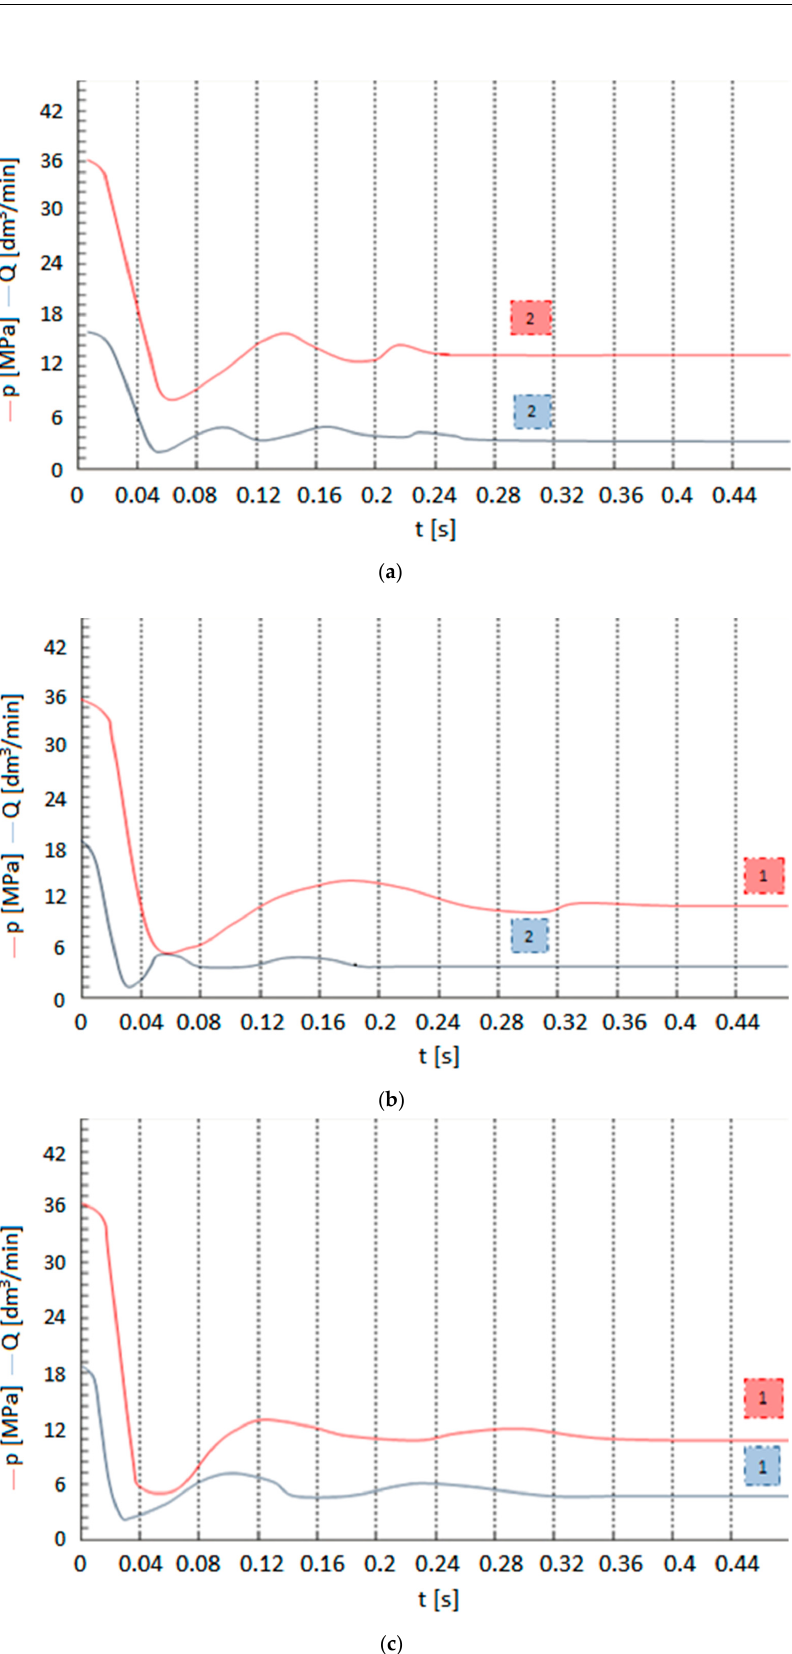
Figure 13. The Q and p time periods for code changes of the K p1 ·K p2 , Q rz , and F m parameters where Q rz : ( a ) 2(320), ( b ) 1(120), and ( c ) 1(020). Runs for a weighting factor value of w i = 2 for ( a ) and w i = 1 for ( b , c ). The multi-valued logical trees with the weighting factors from Table 1 are shown in Figure 14.